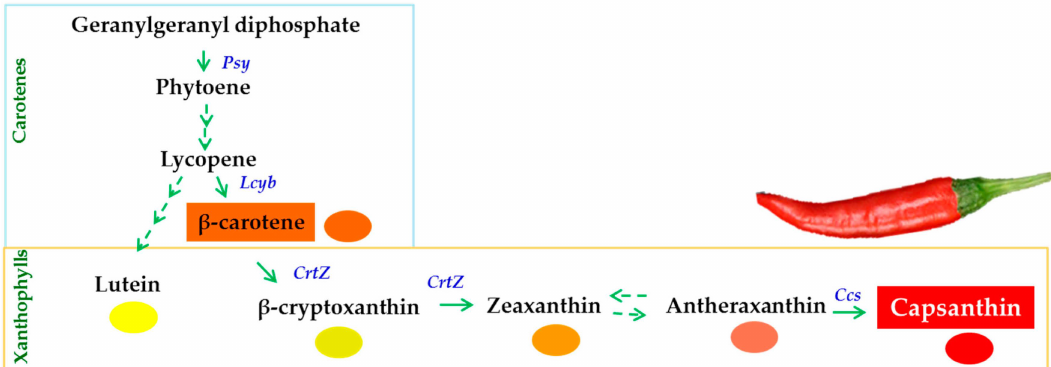
Figure 1. The carotenoid biosynthetic pathway and the key carotenoid biosynthesis-related genes, namely, phytoene synthase ( Psy ), lycopene- β -cyclase ( Lcyb ), β -carotene hydroxylase ( CrtZ ), and capsanthin / capsorubin synthase ( Ccs ), during ripening of Capsicum